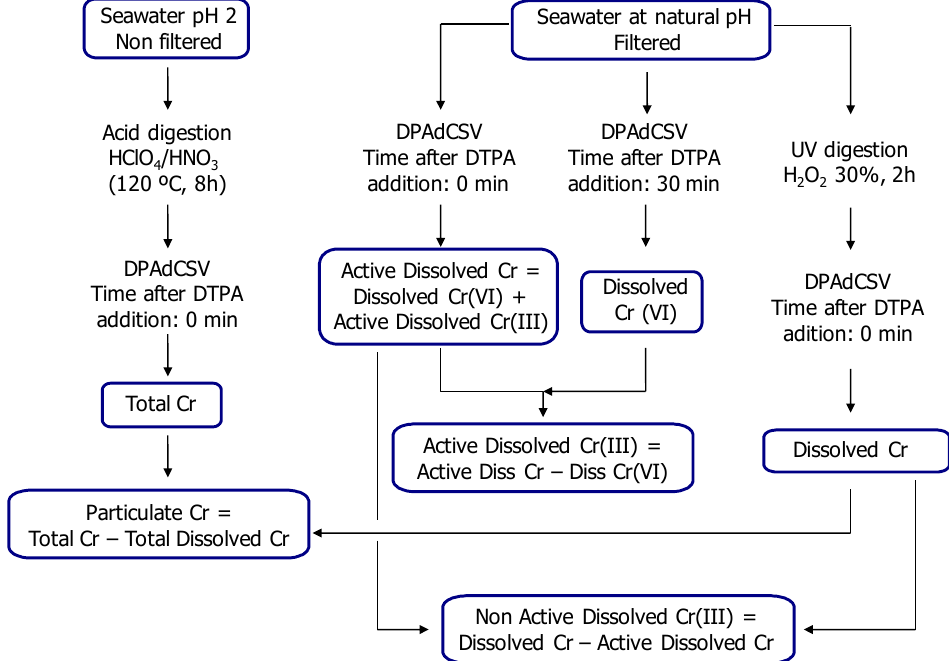
Figure 4. Scheme of chemical fractionation of Cr in water samples.